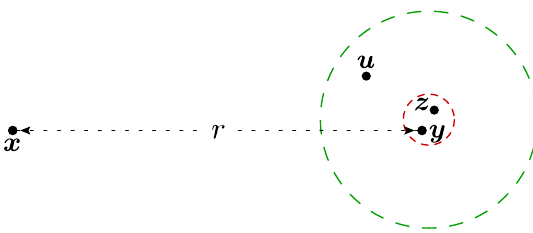
Figure 12 . The transverse coordinates in the strongly ordered regime de(cid:12)ned in eq. (A.10), which in the end leads to the double logarithmic contribution. The points x , y and z are (cid:12)xed and z y are such that r . The point u should be well outside the small (red) circle with radius j (cid:0) j (cid:28) z y . At the same time it should stay inside the larger (green) circle whose radius is much (cid:24) j (cid:0) j z y smaller than r but much larger than j (cid:0) j